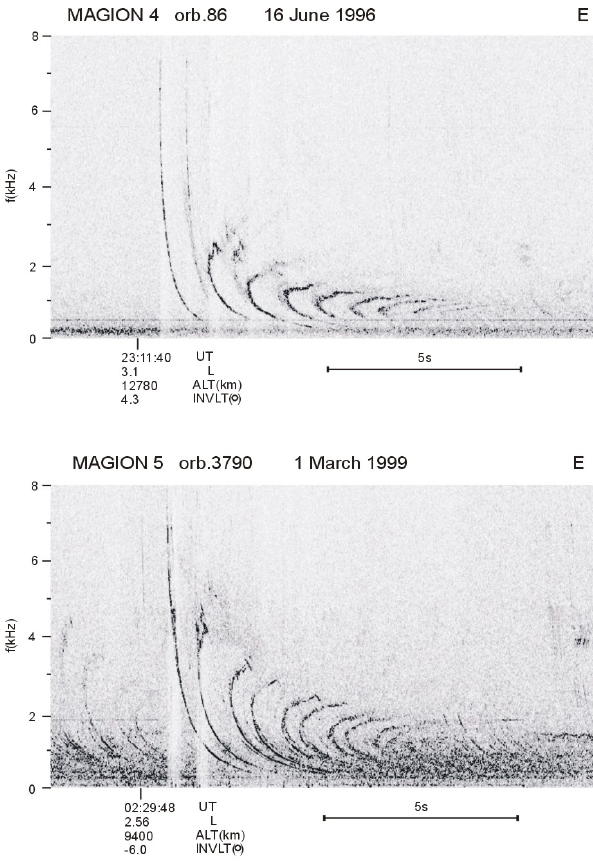
Fig. 1. Examples of MAGION 4 and 5 MR whistler registrations of similar type as observed onboard OGO 1. Positive and negative INVLT correspond to the Northern and the Southern hemispheres,